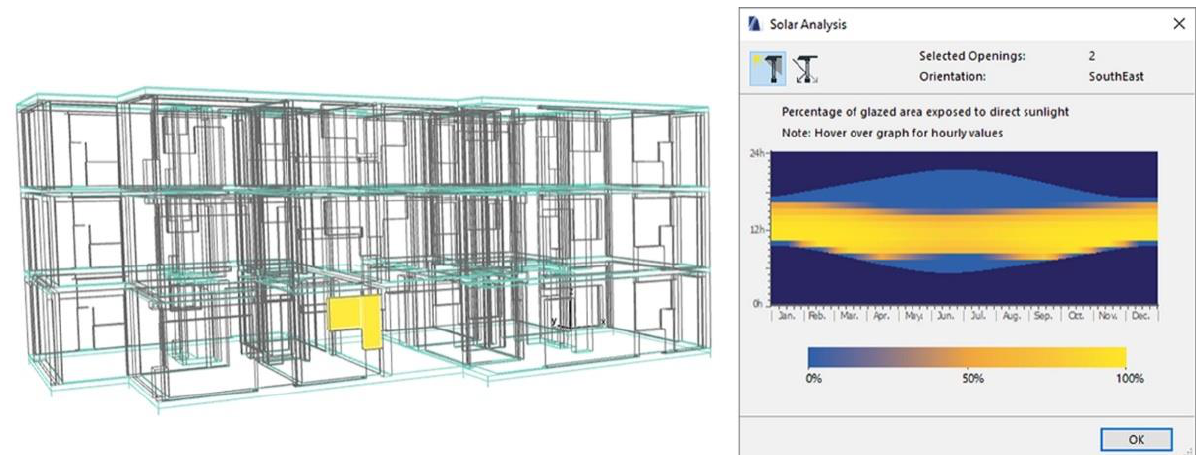
Figure 15. Three-dimensional display of the selected window element and relative solar analysis.